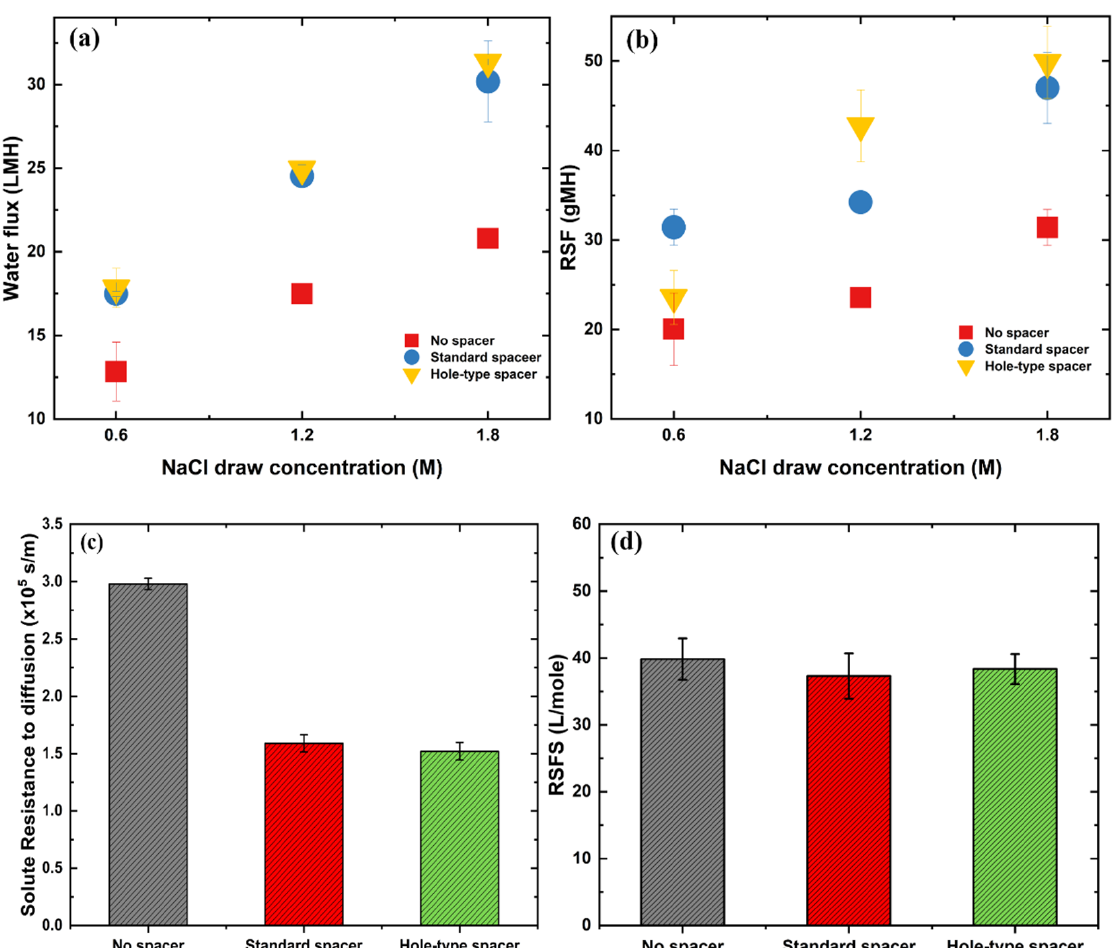
Figure 2. Experimental FO results in absence/presence of spacers (hole-type and standard spacers): ( a ) water flux, ( b ) reverse solute flux (RSF), carried out by using FS as Milli-Q water and various NaCl DS concentrations and calculated based on Equation (1) and Equation (2), respectively, ( c ) solute resistance, and ( d ) reverse solute flux selectivity (RSFS) of the membrane calculated based on Equation (4) and Equation (10), respectively.